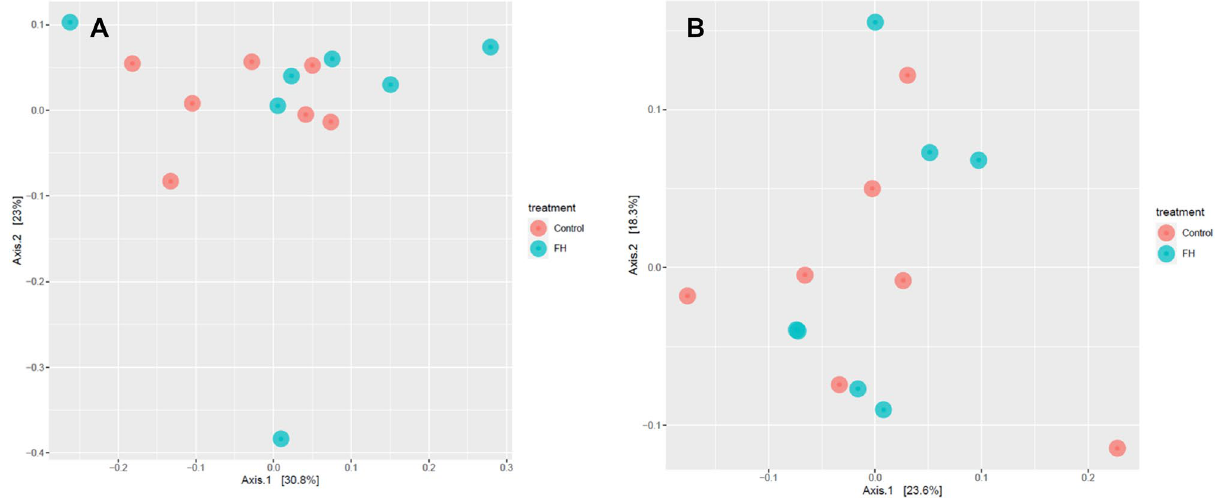
Figure 5. Principal principal coordinate analysis (PCoA) of the similarity of microbiota (OTUs) in anterior and posterior sections ( A , B , respectively) of each individual of S. aurata fed with a Control or N. gaditana hydrolyzed (FH)